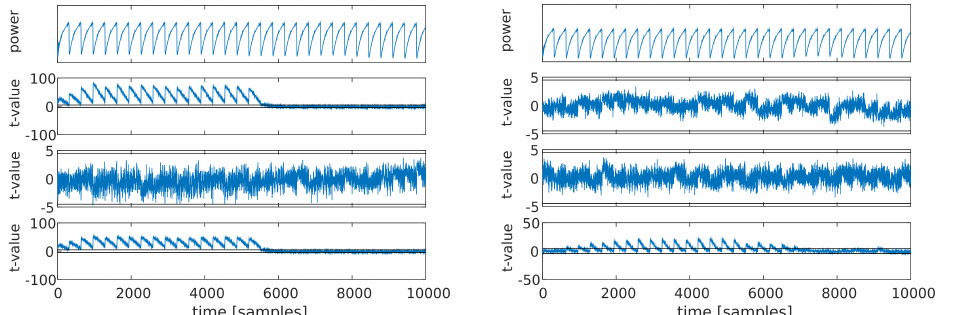
Figure 9: Non-specific t-test on second-order secure M&M AES implementation, V1. Left: PRNG off (24K traces); Right: PRNG on (100M traces). Rows (top to bottom): one exemplary power trace; first-order t-test; second-order t-test; third-order